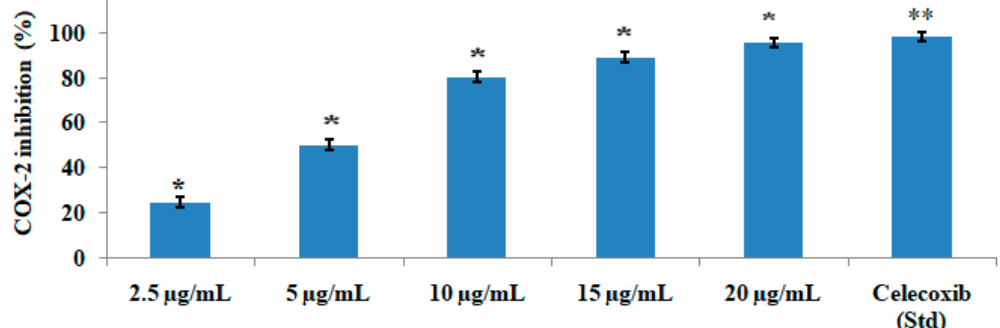
Figure 5. COX-2-inhibitoty activities of various concentrations of quercetin-3-methoxy-4 ′ -glucosyl-7-glucoglucoside. The results represent mean ± SEM (n = 3). * p < 0.05 and ** p < 0.01 compared to the control group.